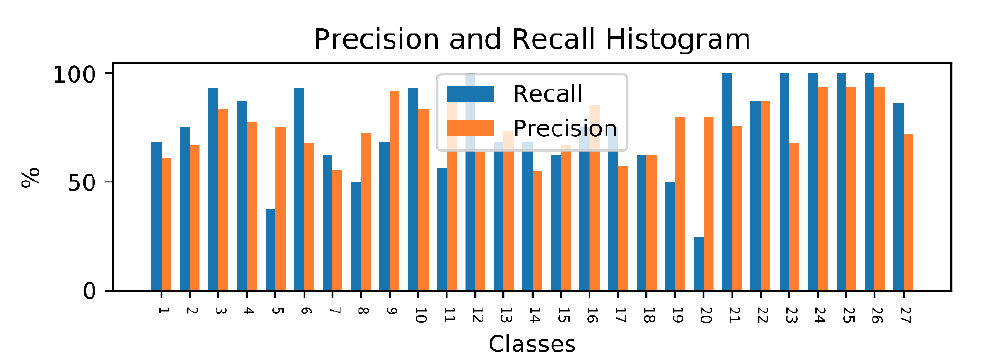
Figure 9. Histogram reporting the precision and recall score for each